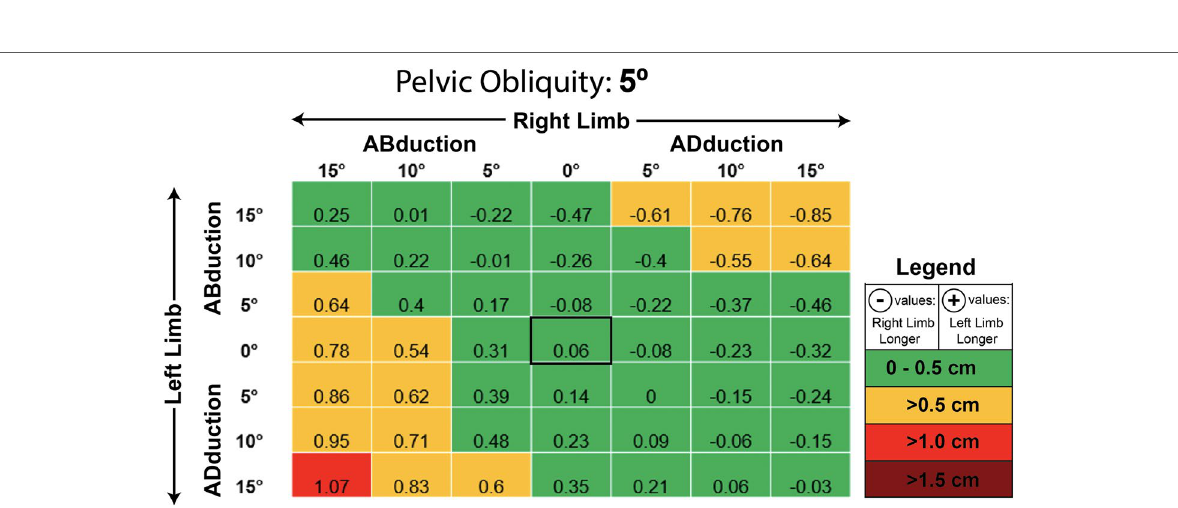
Fig. 5 Measurement error in centimeters seen at varying limb positions when the pelvic is set to 5 degrees of lateral